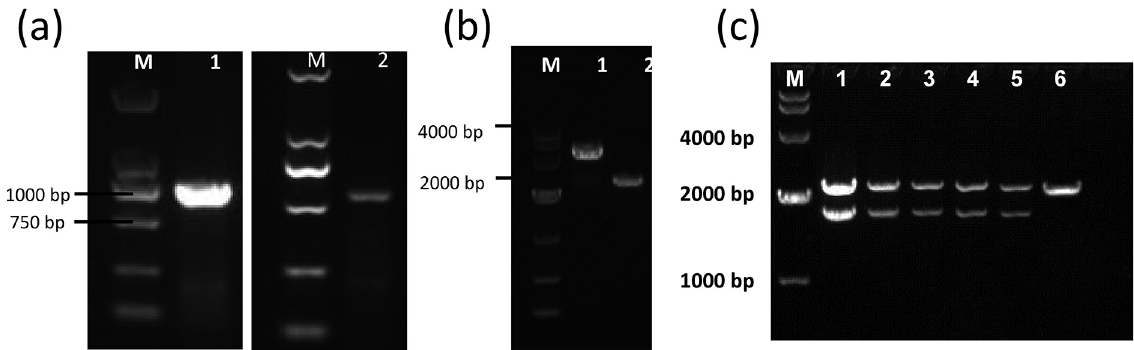
Figure 3- The deletion of LuxS gene did not affect the proliferation ability of E. faecalis . (a) The growth curves of Δ LuxS E. faecalis strain and the ATCC 29212 strain every 2 h from 0 h to 72 h. (b) The CFU counting of Δ LuxS E. faecalis strain and the ATCC 29212 strain